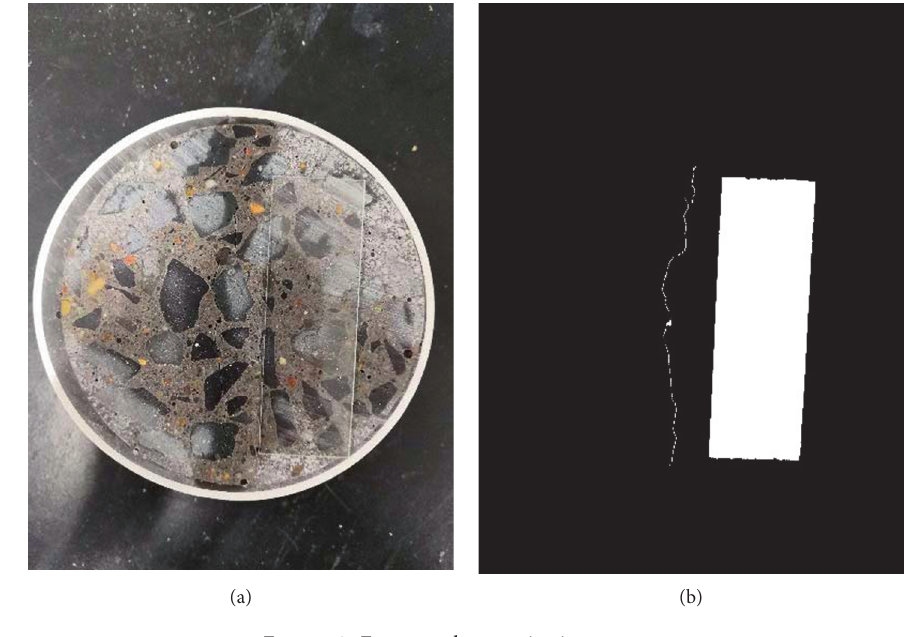
Figure 2: Fracture characterization process. Table 3: Grouping of cracks of different